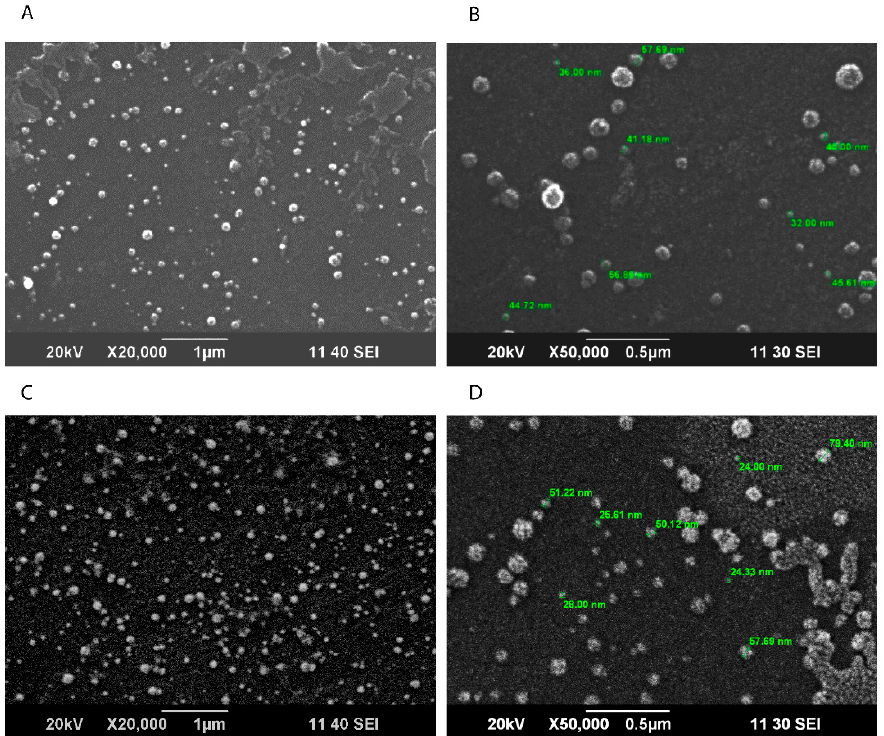
Figure 4. Scanning electron microscopy (SEM) micrographs, ( A , B ) TMZ-loaded SLNPs, at X20,000, scale bar 1 µm and X50,000, scale bar 0.5 µm and ( C , D ) Blank SLNPs at X25000, scale bar 1 µm and X50,000, 0.5 µm.